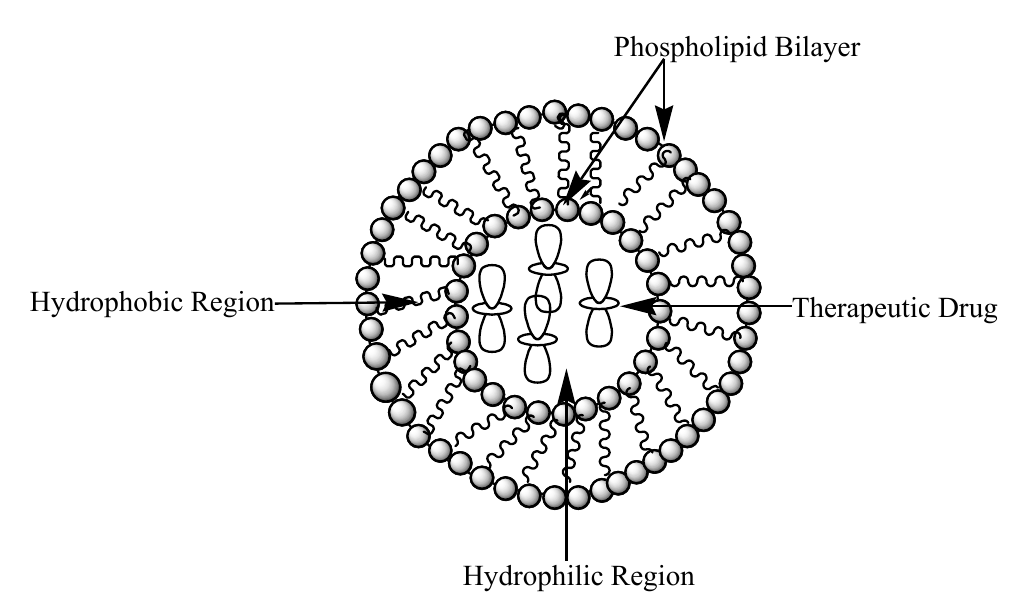
Figure 22. Schematic diagram of a liposome loaded with drug.